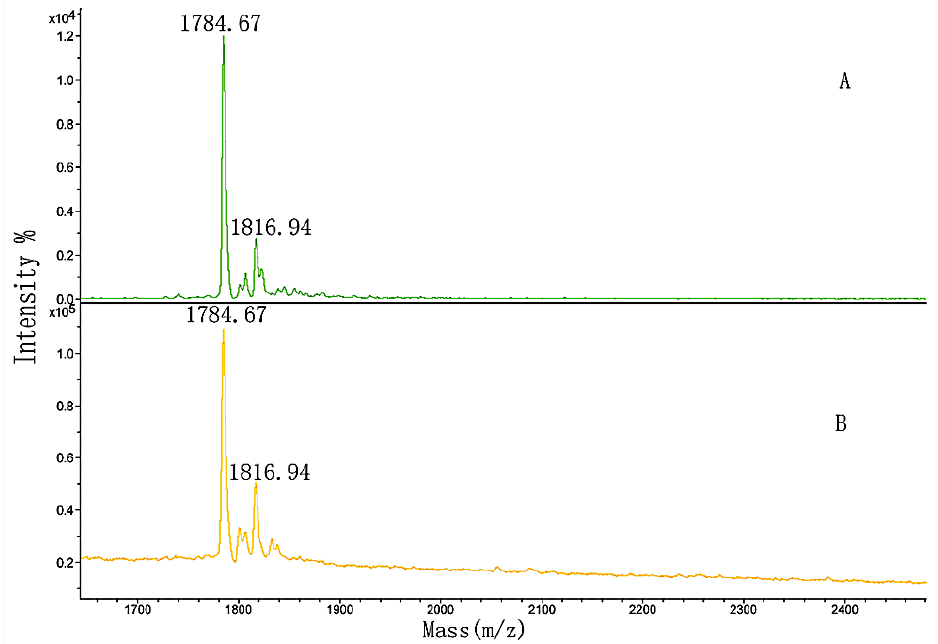
Figure 13. MALDI-TOF MS spectra of ( A ) GPP sample and ( B ) the elution solution. In Figure 12A, m / z 2056.01 and 2088.30 were produced by peptides 1 and 2 from Table 2, respectively, and m / z 2078.19 was m / z 2056.01 + Na + . The figure showed that the washing